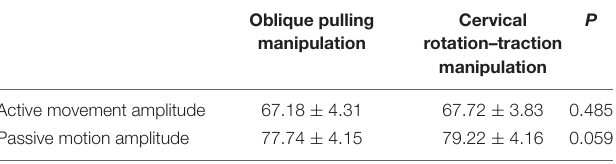
TABLE 3 | Comparion of active and passive motion amplitude between the two groups ( ◦ ).